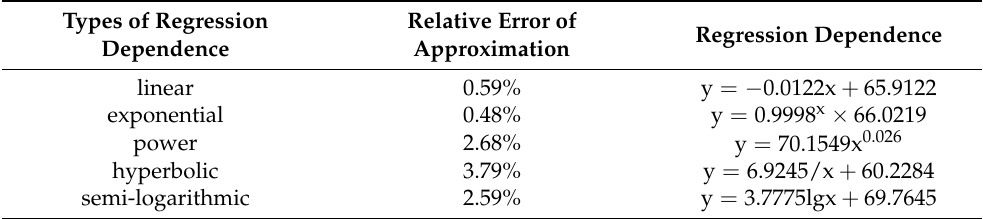
Table 5. Types of regression dependence and their relative errors of approximation in the AMD cooling